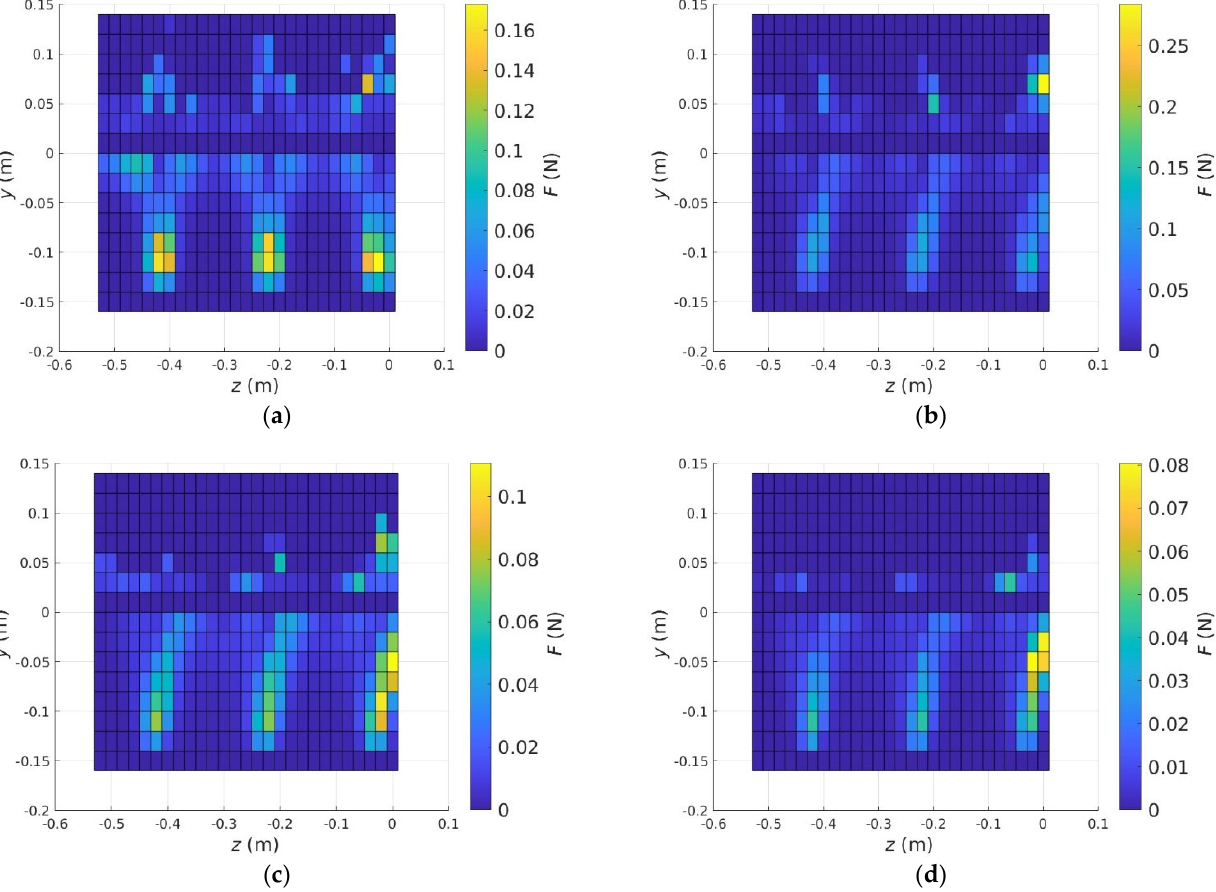
Figure 16. Contour of time ‐ averaged forces acting on particles for various paddle angle of ( a ) 0°, ( b ) 30°, ( c ) 45°, and ( d ) 60°. ( b ) 30 ◦ , ( c ) 45 ◦ , and ( d ) 60 ◦ .